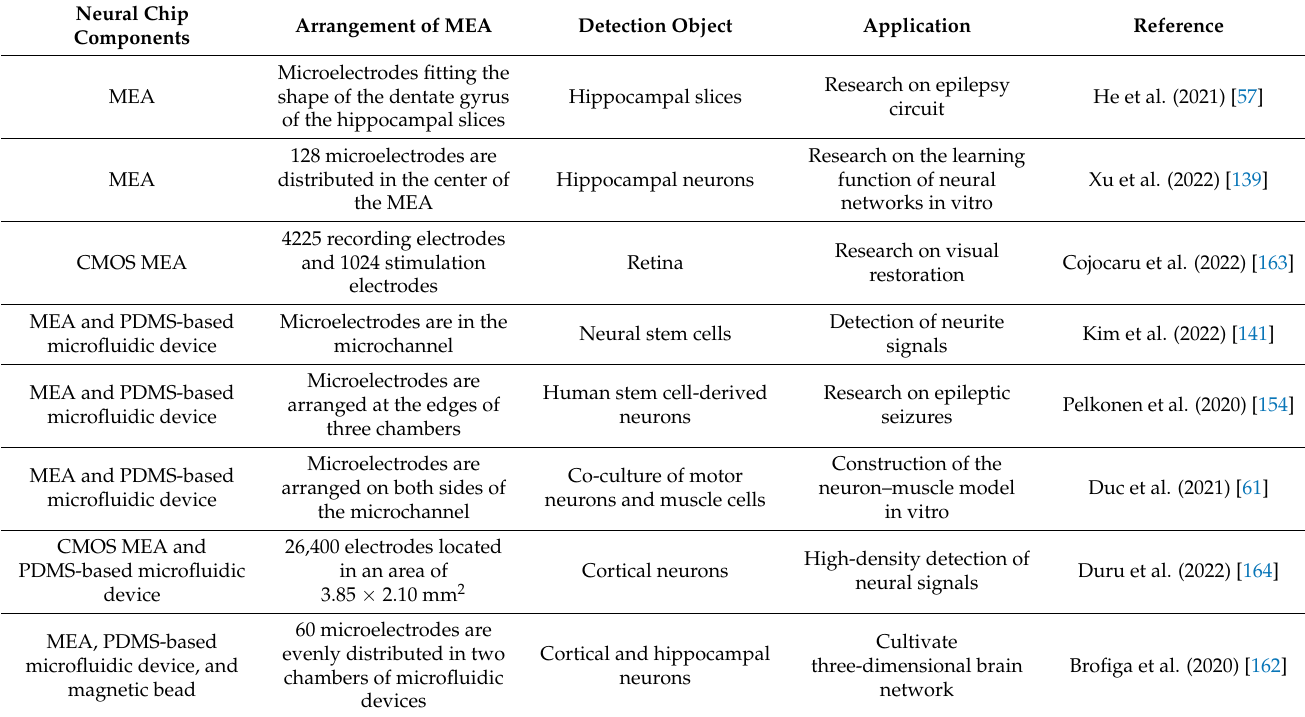
Table 1. Several typical neural chips and their